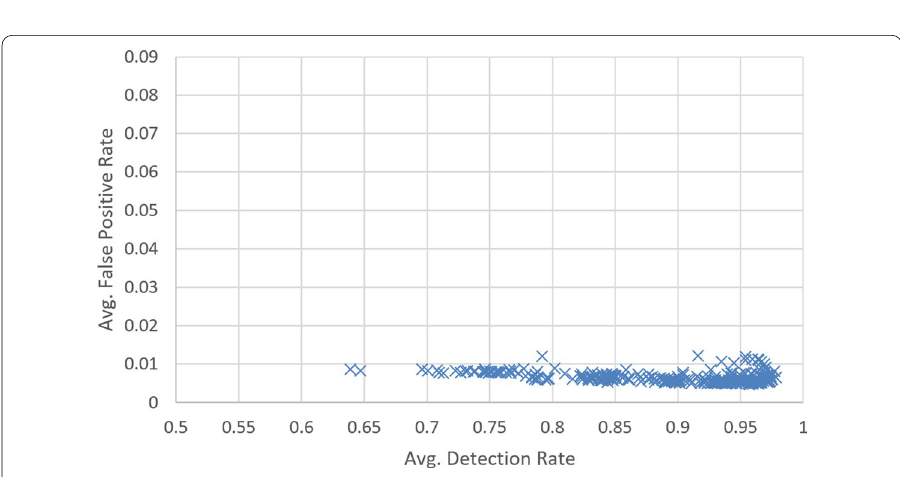
Fig. 10 Test performance of the proposed approach for